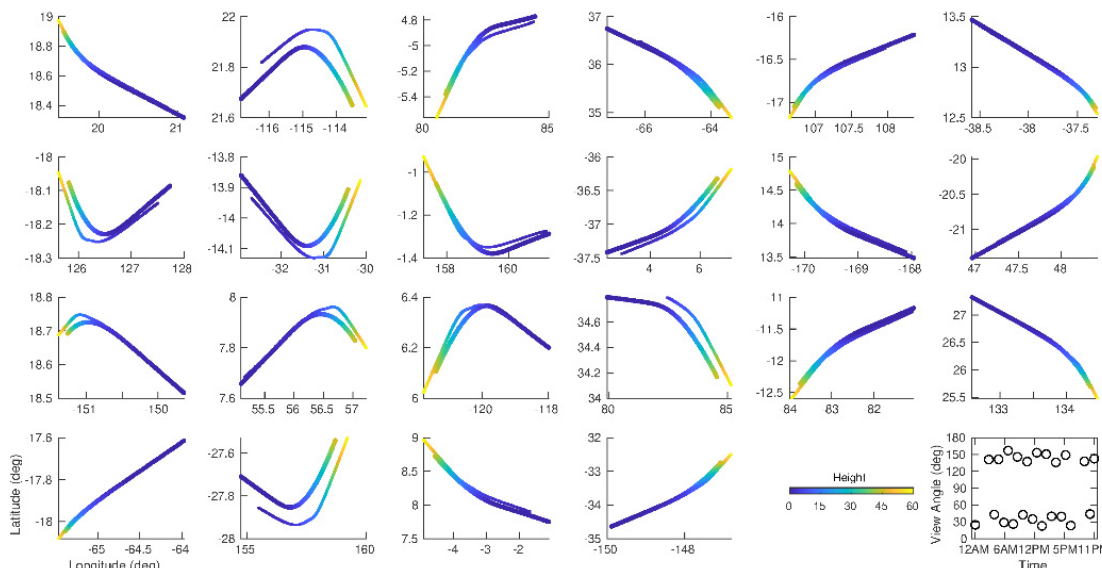
Figure 3. Predicted (thick dashed line) and observed (thin dashed line) RO event ground track comparison for receiver C2E1 and emitter G01 on 1 January 2021. The scatter plots show the mean sea level height as a function of latitude and longitude, as indicated by the colored bar. There are 22 matched pairs between observation and prediction; the view angle for each RO event was also plotted.